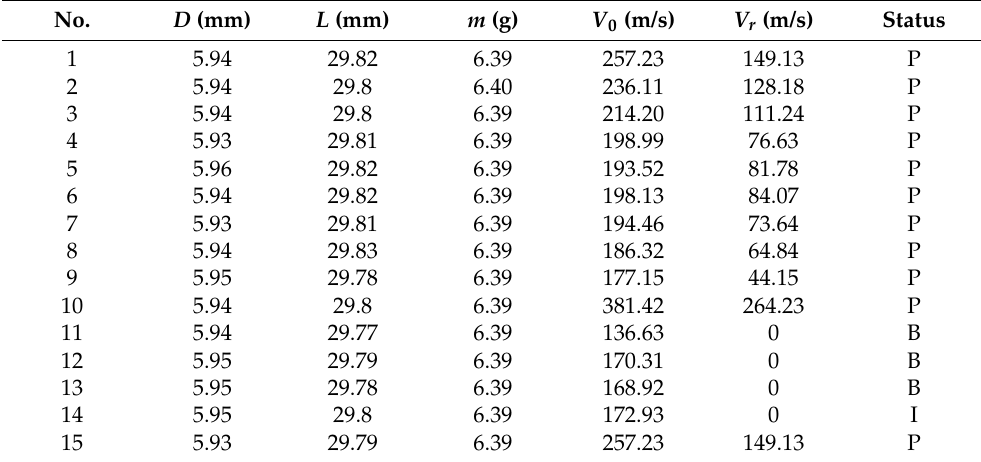
Table 1. The ballistic test results of Weldox 900 E steel targets.